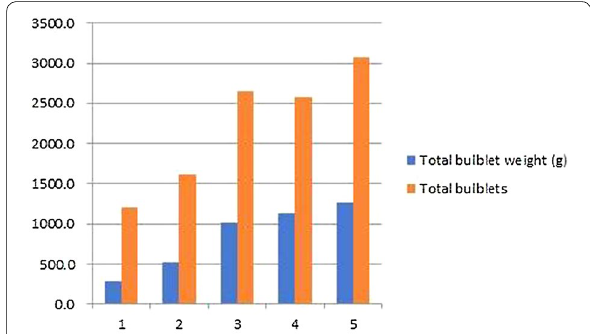
Fig. 3 F. cirrhosa : Total number of bulblets and weight (g) after each subculture (at 2 months interval)